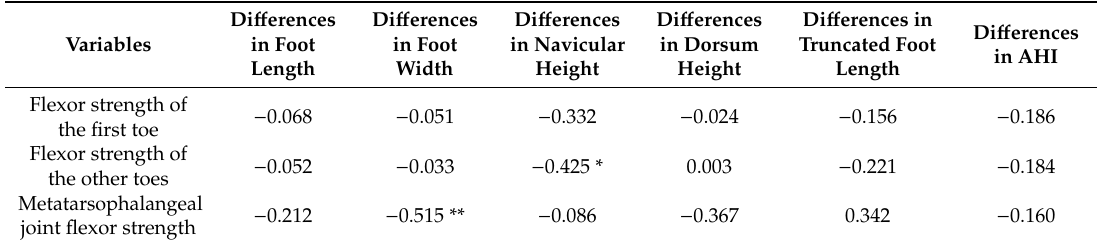
Table 5. Correlation coe ffi cient of di ff erences in foot morphology and foot muscle strength with adjustment to age and BMI.